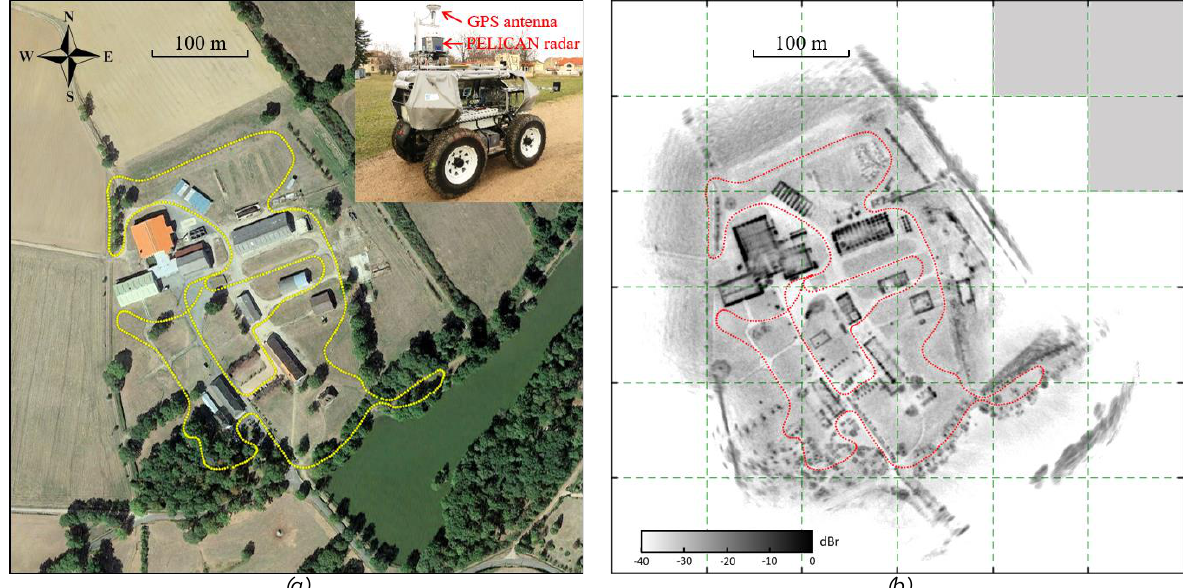
Figure 7. Example of radar map construction. (a) Aerial image of the test zone. Yellow dots indicate the trajectory (GPS data) followed by the robot. The upper-right image shows PELICAN radar positioned on AROCO robot. (b) 2D radar map. The red dots indicate the computed radar trajectory.